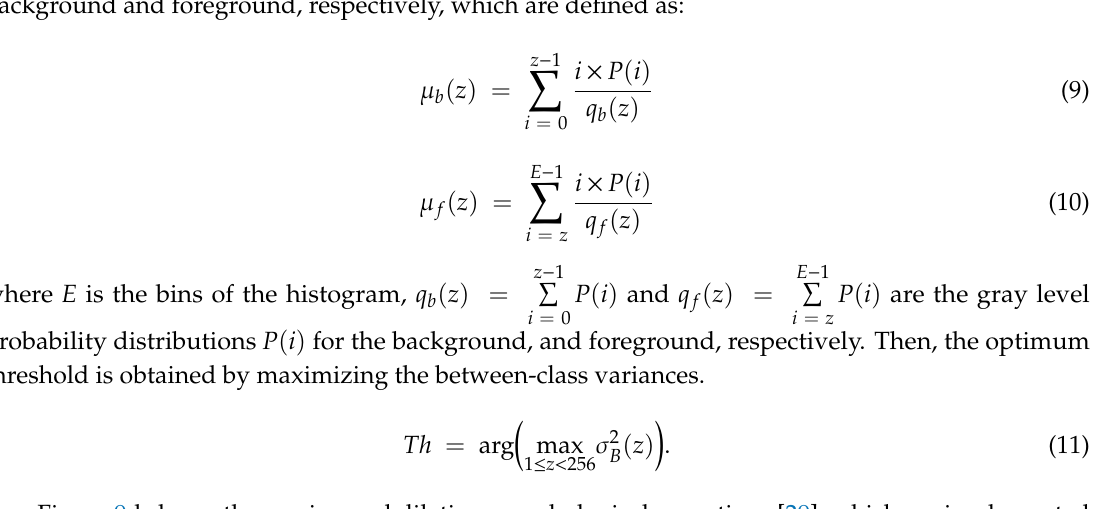
Figure 9. ( a ) Tarsal bone detection; ( b ) Calcaneus region; ( c ) Binary image of calcaneus region; and ( d ) Calcaneus region after morphological operations. Calcaneus region after morphological